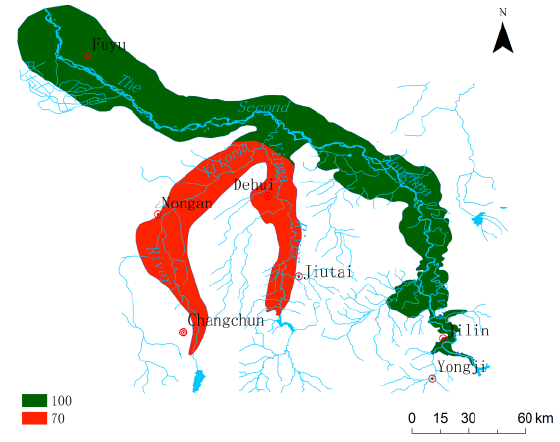
Figure A2. Distribution of aquifer thickness scores.